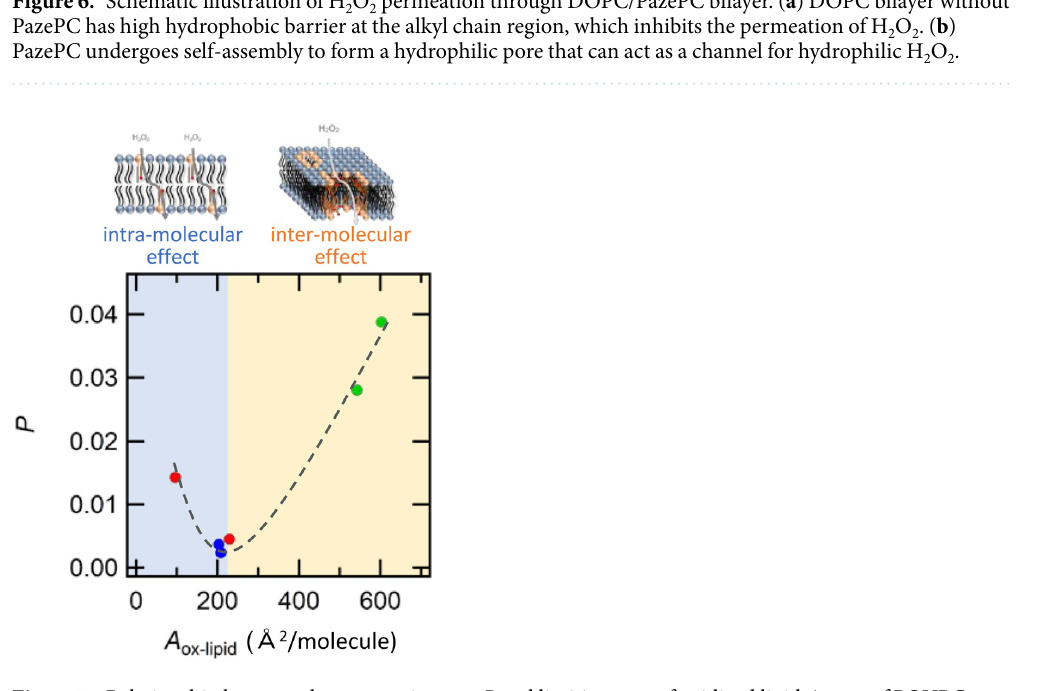
Figure 7. Relationship between the permeation rate P and limiting area of oxidized lipid A ox-lipid of POVPC (red), PoxnoPC (blue), and PazePC